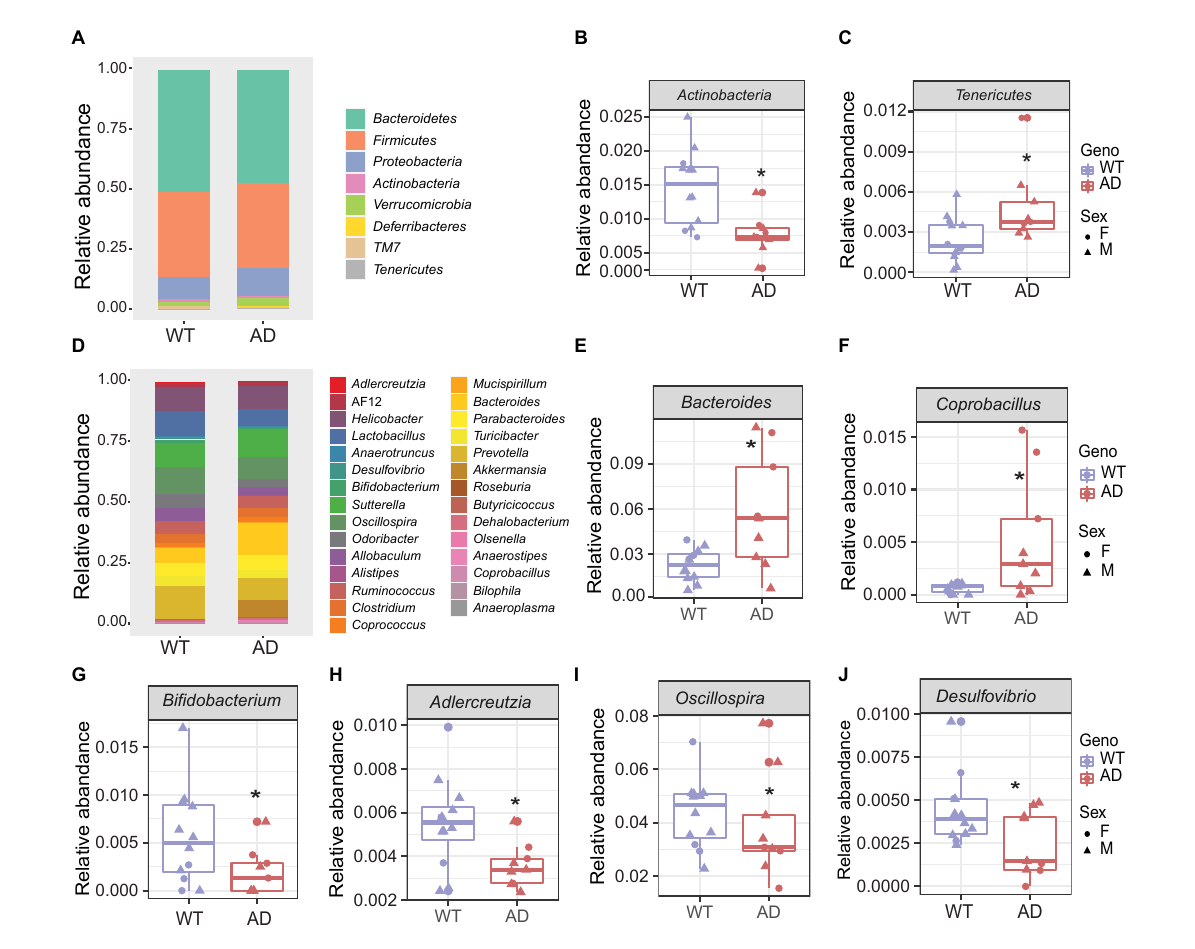
FIGURE2 The gut microbial compositions of Alzheimer’s disease (AD) mice differed from wild-type (WT) mice. (A) Stacked bar chart showing the microbiome composition at the phylum level. (B,C) The relative abundances of Actinobacteria (B) decreased, and Tenericutes (C) increased in AD mice compared with WT mice. * P < 0.05, AD ( n = 9) versus WT ( n = 11); Welch two-sample t -test. (D) Stacked bar chart showing the microbiome composition at the genus level. (E–J) The relative abundances of genera Bacteroides , Coprobacillus , Bifidobacterium , Adlercreutzia , Oscillospira , and Desulfovibrio . * P < 0.05; Welch two-sample t -test. Data are shown as all samples with a boxplot. F, females; M, males; * P < 0.05, AD ( n = 9, 6 males and 3 females, 12-month-old) versus WT ( n = 11, 9 males and 3 females,